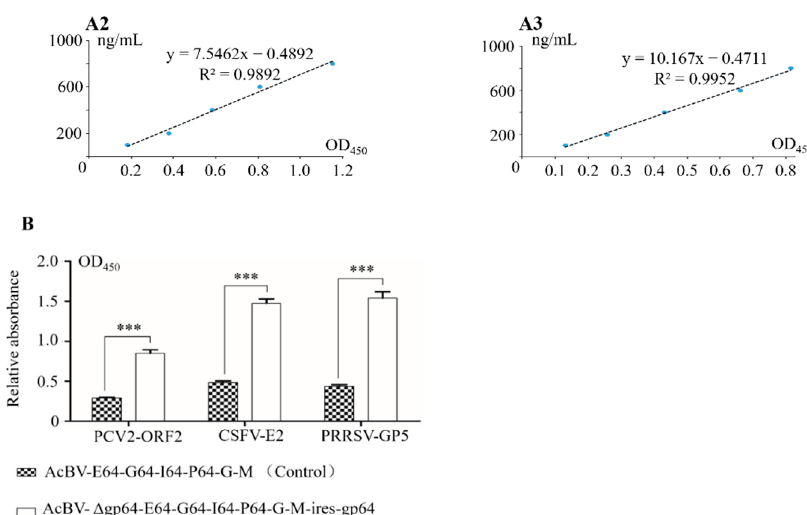
Figure 10. Determination the display efficiency of the antigens on the baculovirus capsule. ( A1 ) ELISA standard curve of antibody (PCV2-ORF2—OD 450 ). ( A2 ) ELISA standard curve of antibody (PRRSV-GP5—OD 450 ). ( A3 ) ELISA standard curve of antibody (CSFV-E2—OD 450 ). ( B ) The display efficiency of envelope antigens was determined by ELISA (***: p < 0.01).